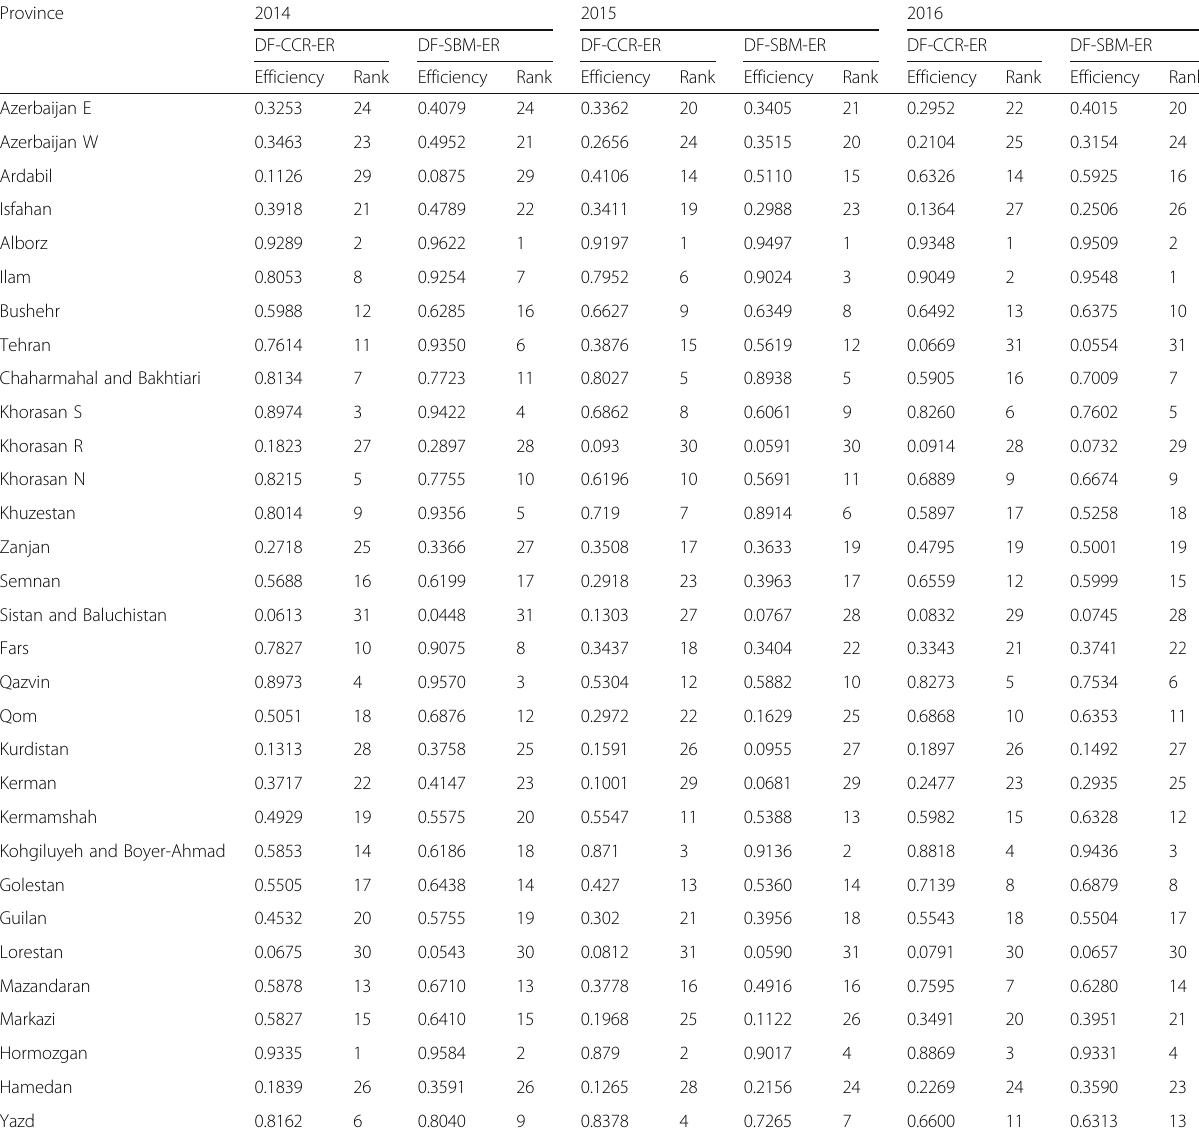
Table 6 Comparisons between the Efficiency results for Iranian road safety performance obtained using DF-SBM-ER and DF-CCR- ER [15]